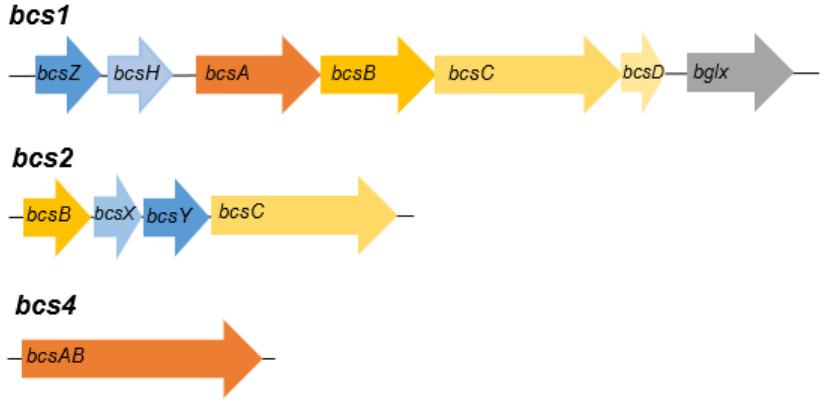
Figure 3. Structure of operons bcs1 , bcs2 and bcs4 of Komagataeibacter melomenusus AV436 T . The gene sizes are presented relatively to each other. Gene symbols are taken from publication of Römling and Galperin [62]. The gene symbols correspond to the following product: bcsZ ,